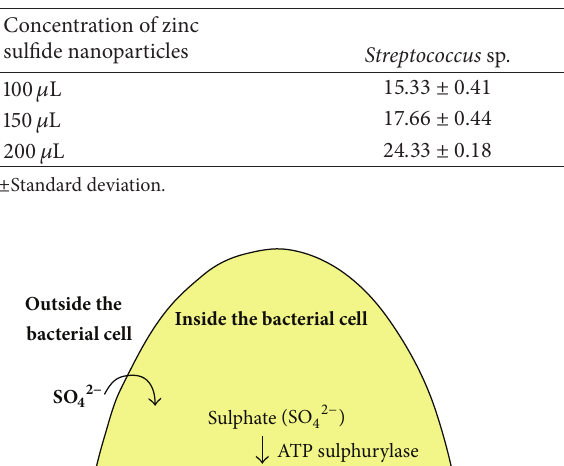
Table 2: Antimicrobial activity of ZnS nanoparticles against oral pathogens.